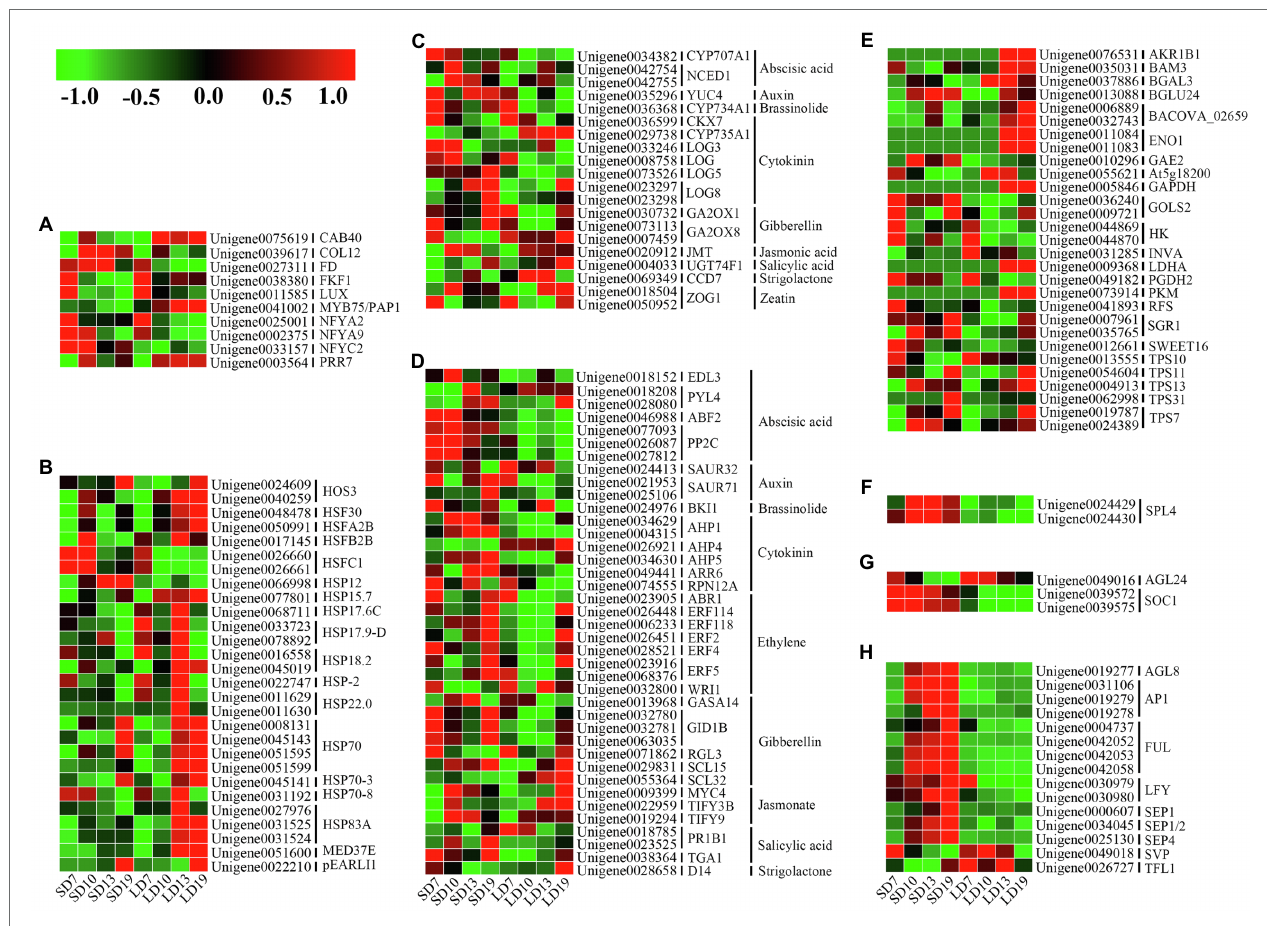
FIGURE 5 | Expression profiles of genes associated with L. gratissima floral transition at four developmental stages, short- or long-day treatments. Relative expression profile of (A) photoperiod pathway-related genes, (B) ambient temperature pathway-related genes, (C) phytohormone metabolism-related genes, (D) phytohormone signal transduction-related genes, (E) sugar signal-related genes, (F) aging pathway-related genes, (G) floral integrator-related genes, and (H) floral meristem identity genes. The Z-score normalized RPKM value for an individual gene at a given developmental stage is represented in a green (low expression) to red (high expression)